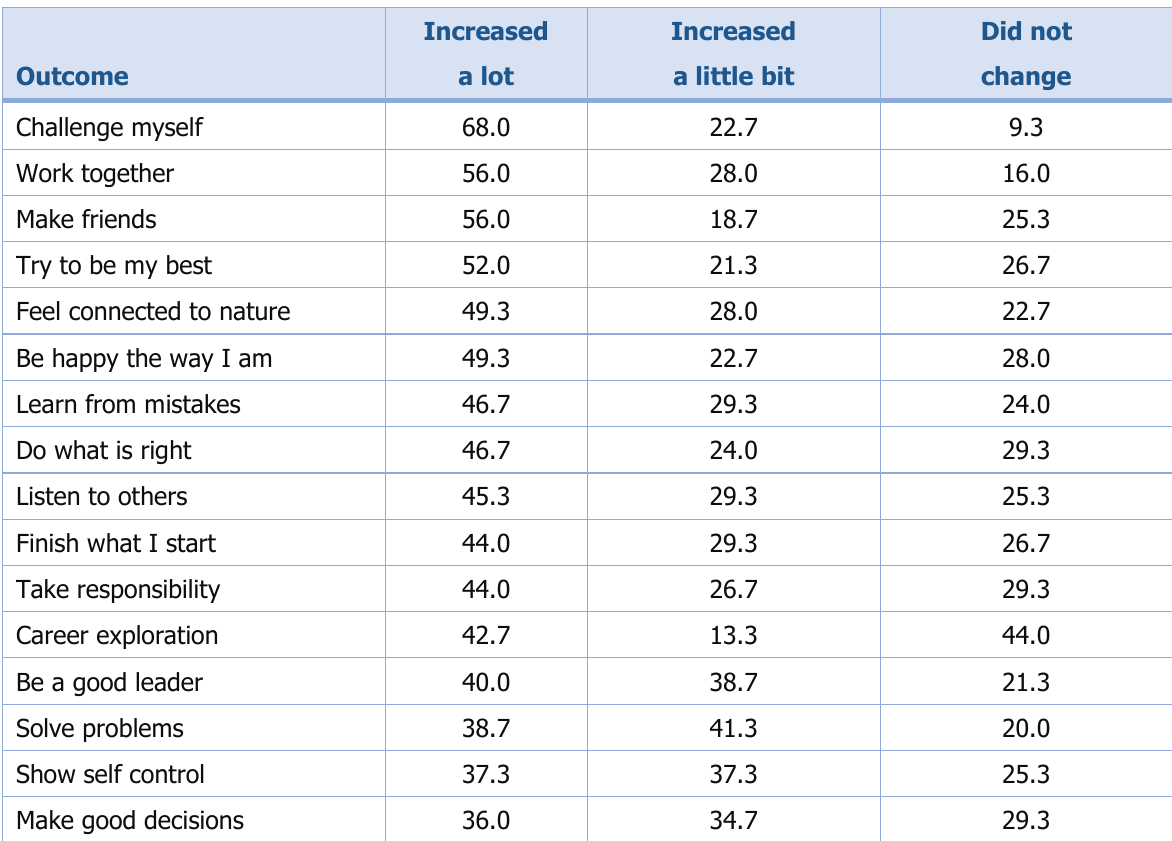
Table 1. Percentage (%) of Youth Who Reported Personal Growth Linked To Short- Term Outdoor Adventure Camp Participation (n = 75)